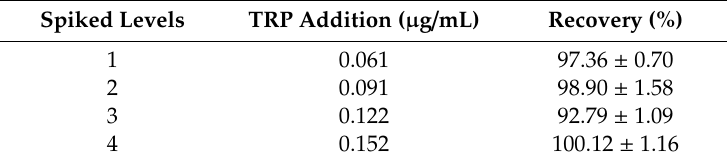
Table 1. Accuracy of the method expressed as Recovery (%) in yoghurt